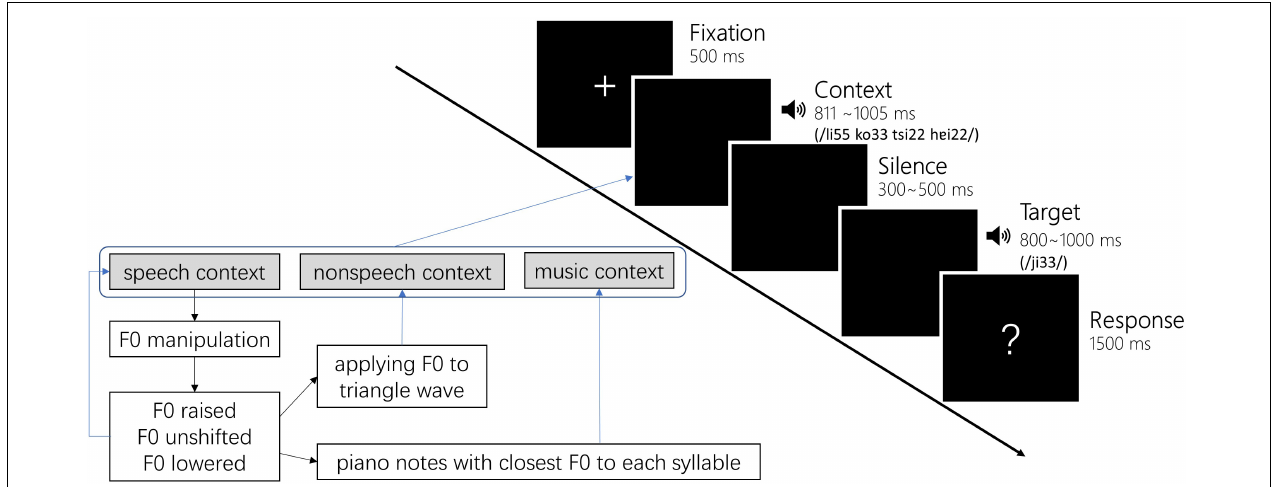
FIGURE 1 | Trial procedure of the word identification task and a schema depicting the context